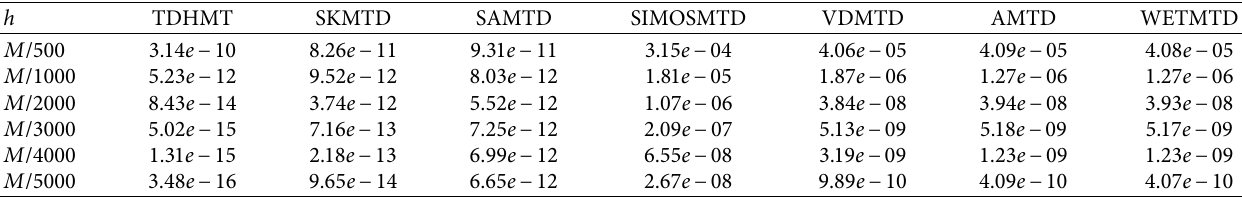
Table 1: Comparison of the absolute errors at the end point of TDHMT with absolute error of other existing methods, namely, SKMTD, SAMTD, SIMOSMTD, VDMTD, AMTD, and WETMTD for Example 1. h